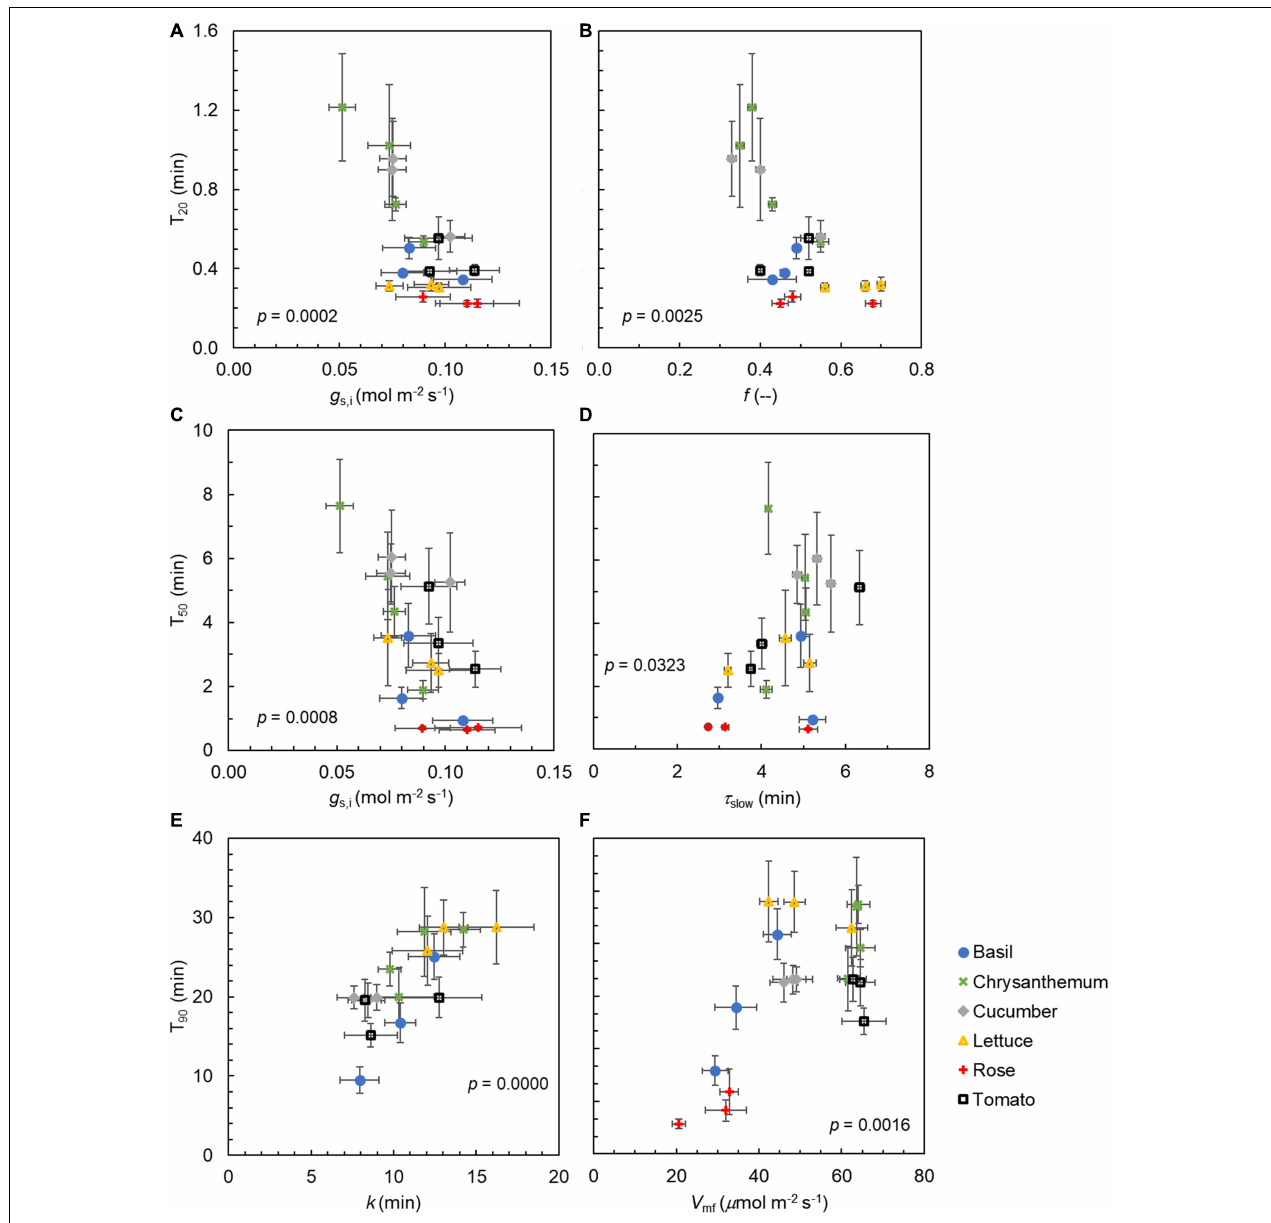
FIGURE 8 | Relationships between (A) initial stomatal conductance in low irradiance ( g s , i ) and time to reach 20% of full photosynthetic induction ( T 20 ), (B) the weighting factor f describing the kinetics of maximum Rubisco carboxylation rate ( V cmax ) during photosynthetic induction and T 20 , (C) g s , i and time to reach 50% of full photosynthetic induction ( T 50 ), (D) the time constant for the slow phase of V cmax induction ( τ slow ) and T 50 , (E) time constant k for stomatal opening and time to reach 90% of full photosynthetic induction ( T 90 ), and (F) final V cmax under 15 min of high irradiance ( V mf ) and T 90 . Datapoints are means ± SE ( n = 6–9). Values shown are p -values of Pearson correlation. Data for rose is not presented in (E) due to absence of stomatal